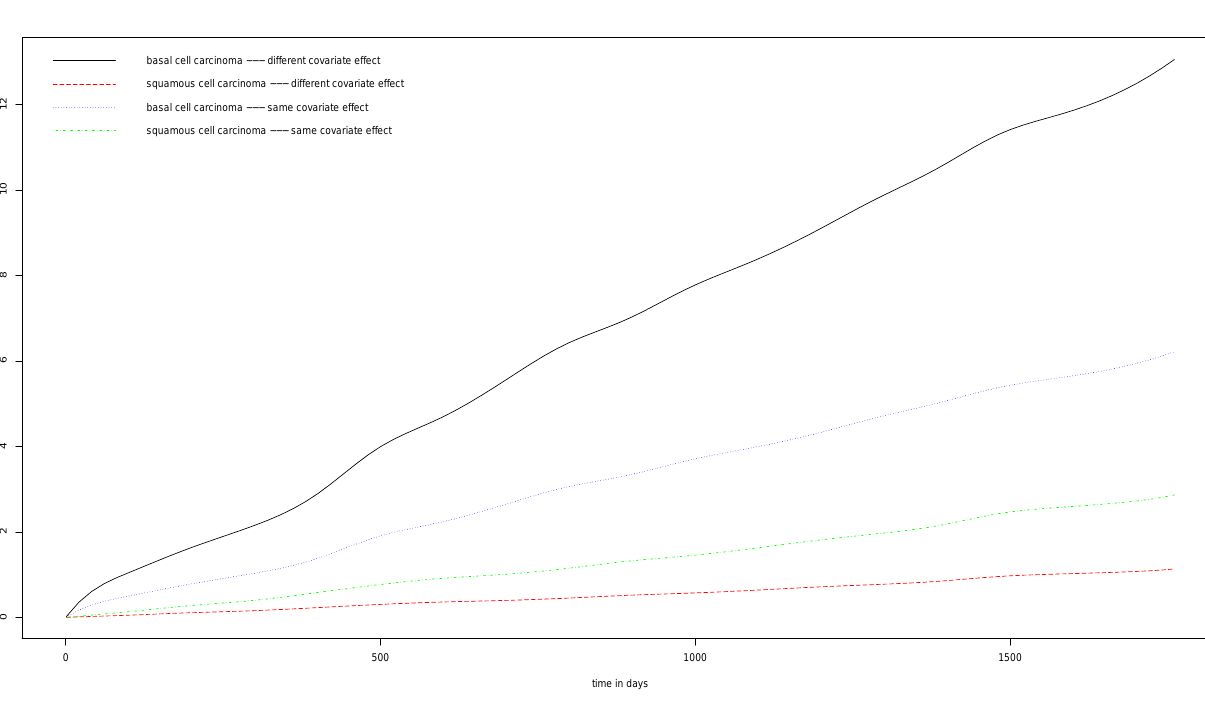
Figure A3. Simulation results: estimation of baseline correlation function for models with different α and η values. The solid lines represent the true baseline mean function and the broken lines represent the estimated baseline mean function.